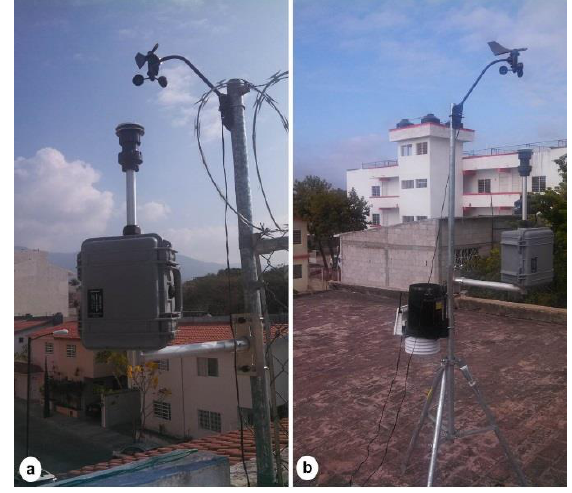
Figure 3. PM 10 monitoring stations at the study sites. ( a ) Site located downwind from Lajas Maciel. ( b ) Site located downwind from Plan de Ayala.